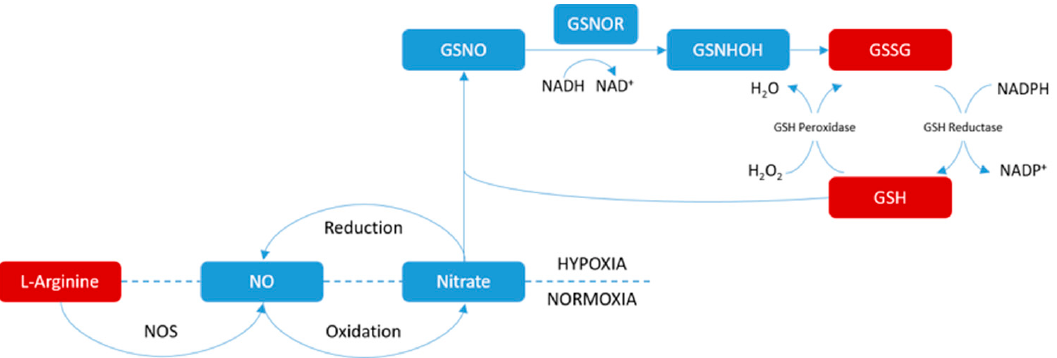
Figure 5. Part of the nitric oxide signaling pathway.